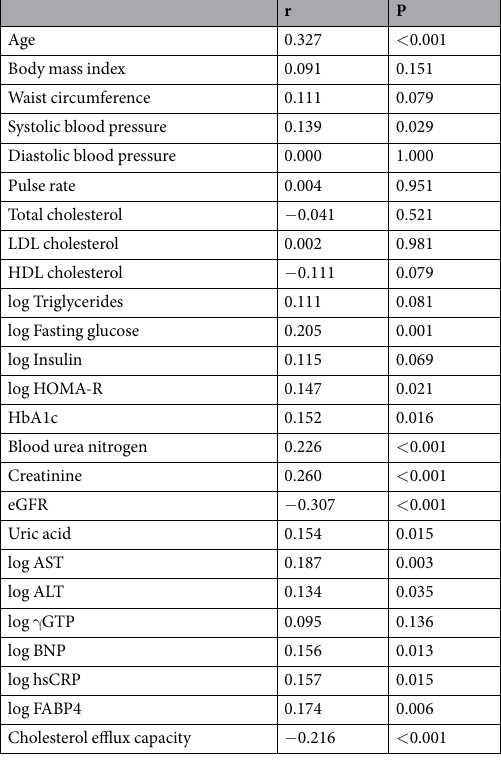
Table 3. Correlation analysis for log FABP5 (n = 250). AST, Aspartate transaminase; ALT, Alanine transaminase. BNP, brain natriuretic peptide; CEC, cholesterol efflux capacity. eGFR, estimated glomerular filtration rate. FABP4, fatty acid-binding protein 4; FABP5, fatty acid-binding protein 5. γ GTP, γ -glutamyl transpeptidase; hsCRP, high-sensitivity C-reactive protein.